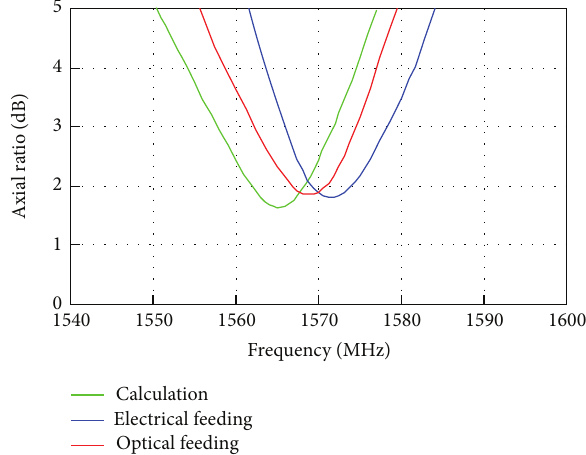
Figure 14: Frequency characteristics of axial ratio.